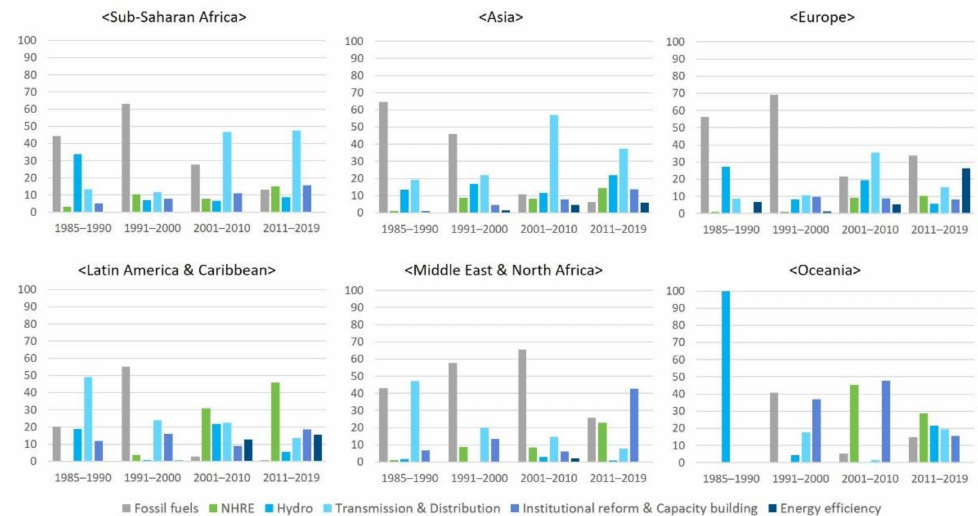
Figure 8. Share of each sector in energy finance by region and period. Source: authors’ illustration based on